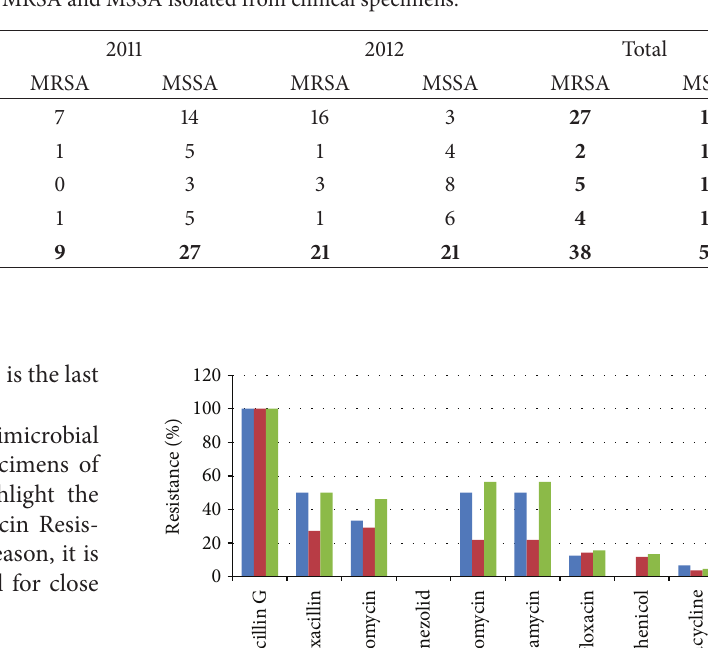
Table 1: Distribution of MRSA and MSSA isolated from clinical specimens.